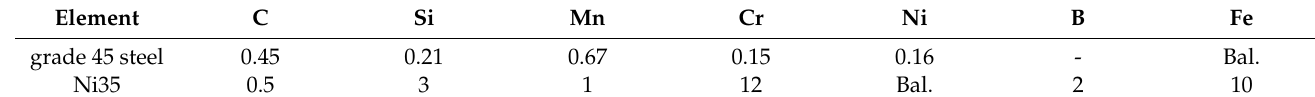
Table 1. Chemical composition of grade 45 steel substrate and Ni35 (wt.%).